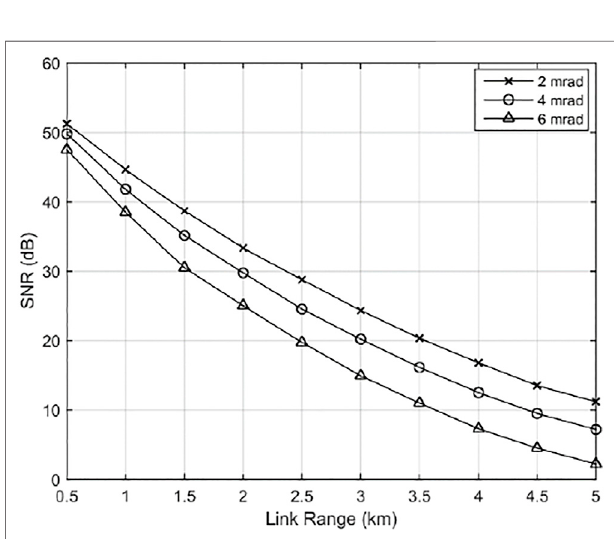
FIGURE 6 | Quality Factor vs. Link Range for different beam divergence